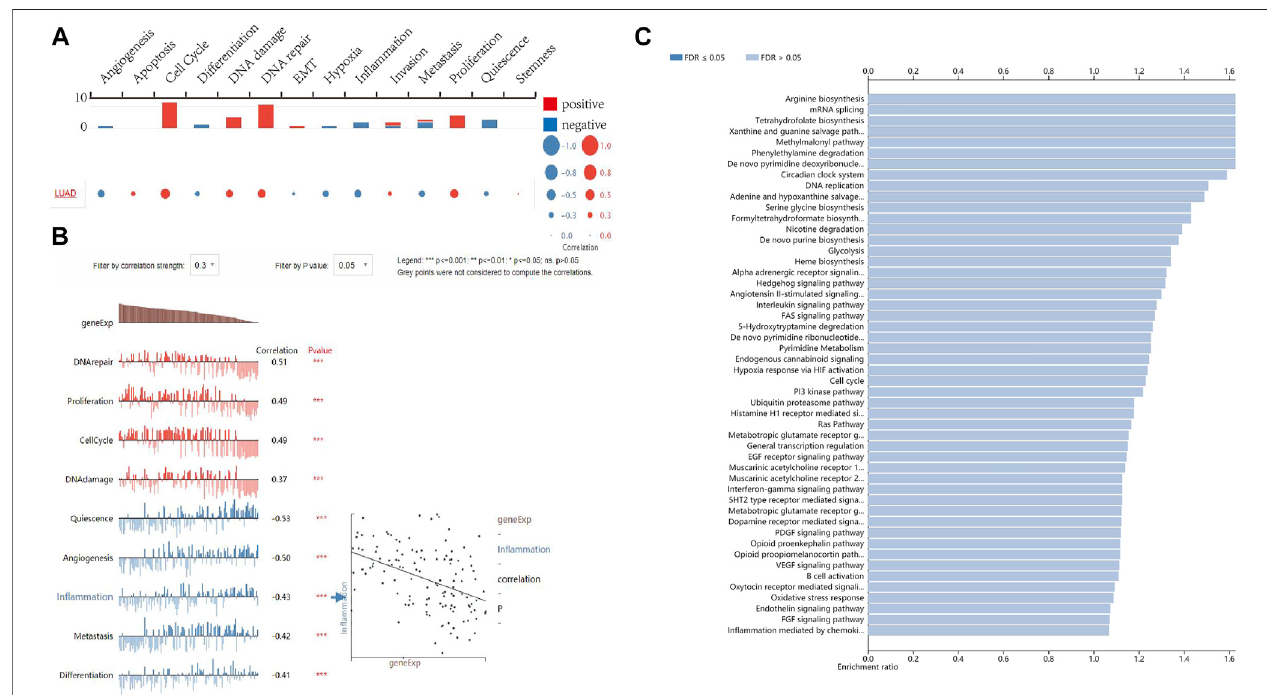
FIGURE7| ThefunctionofFANCD2inLUAD. (A,B) Thesingle-cellanalysisshowsthatFANCD2isinvolvedinthecellcycle,DNArepair,proliferation,angiogenesis, quiescence, in fl ammation, metastasis, and differentiation. (C) The biological processes related to FANCD2 are based on